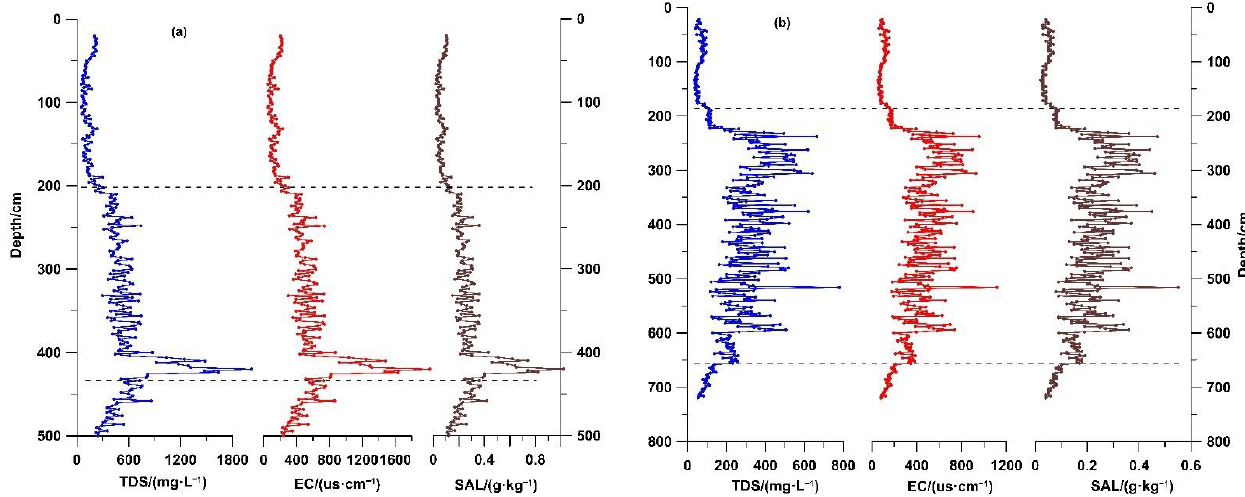
Table 1. Changes of physicochemical properties of sediment lixiviums of GX and CYK profiles.